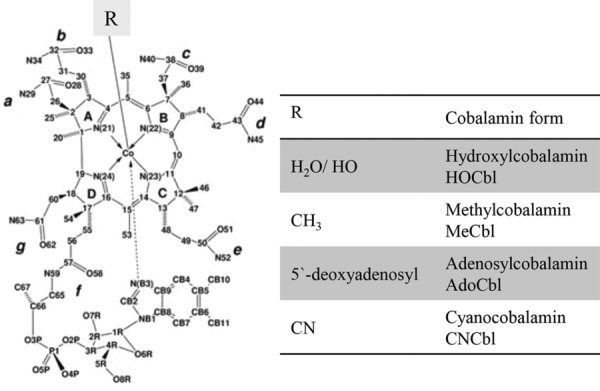
Vitamin B12 chemical structure and forms. R is bound to the upper (β-face).